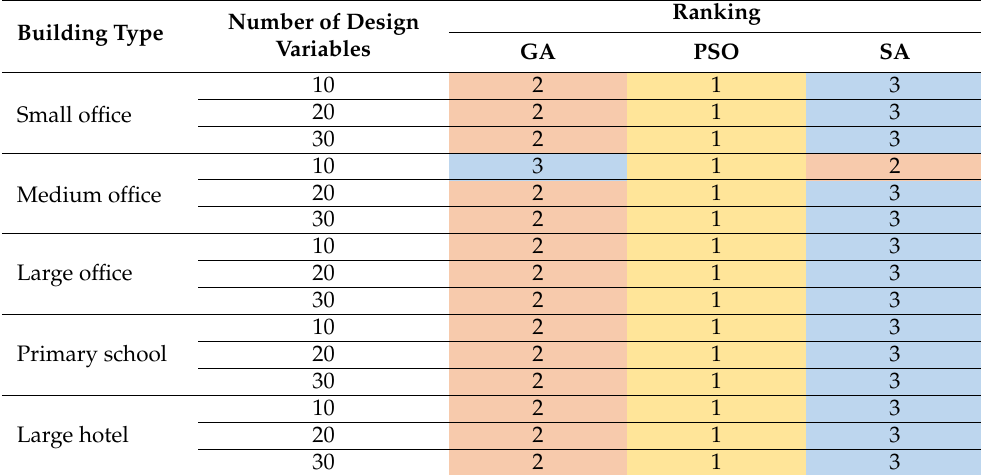
Table 10. Ranking results of the optimal design quality obtained by the three single-objective test algorithms when using the optimal HPSs.